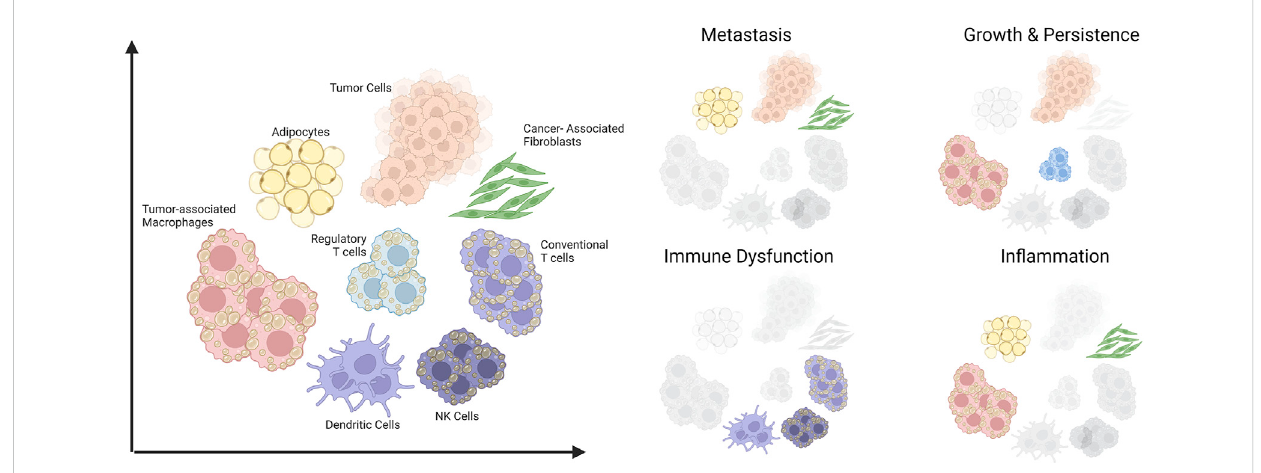
FIGURE 1 Schematic summary of cells in the tumor microenvironment that are amenable to lipid-induced metabolic programming and their contributions to aspects of cancer progression. The scope of thisreview covers various cell typeswithin thetumor microenvironment (Left) and their involvement infour key aspects of tumor progression (Right) . Created with BioRender.com.